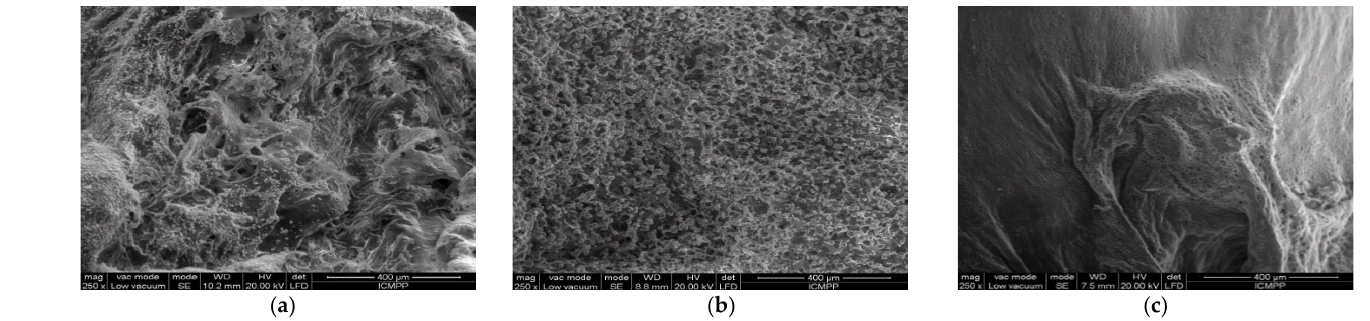
Figure 6. Typical SEM pictures of the compounds/formulations: ( a ) SEM ‐ P 1 ; ( b ) SEM ‐ P 2 ; ( c ) SEM ‐ P